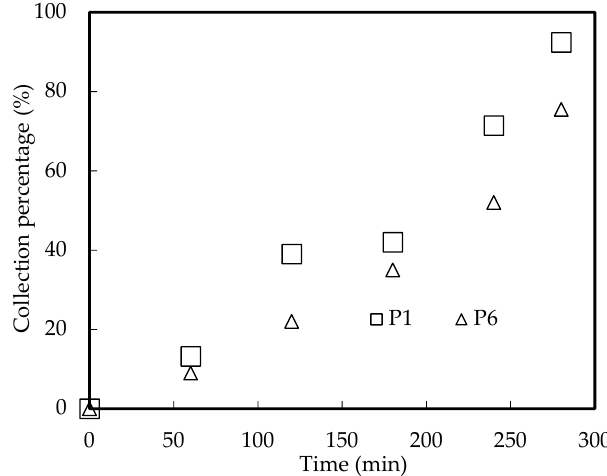
Figure 14. Influence of tube holes’ proportion.